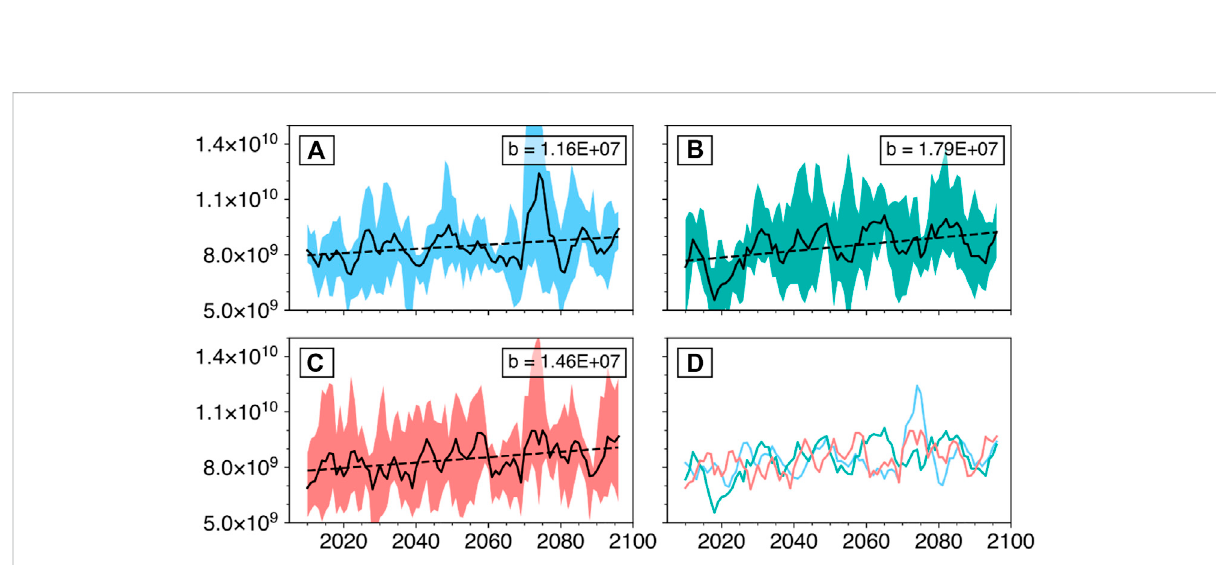
FIGURE 4 The annual mean Power Dissipation Index (PDI) of tropical cyclones from 2006 to 2100, calculated from simulations under (A) 1.5degNE, (B) 1.5degOS, (C) 2.0degNEscenarios.Theshadedarearepresentstheensemblerange,theblacksolidlinetheensemblemean,andtheblackdottedline the result of linear regression. (D) Ensemble means of the annual mean (PDI) in the 1.5degNE (blue), 1.5degOS (green), 2.0degNE (red)